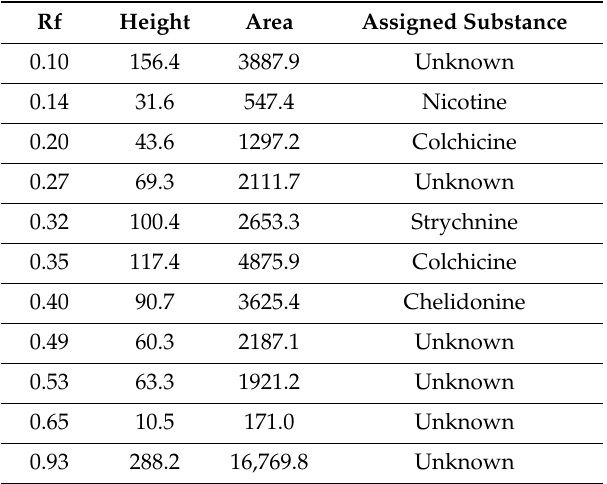
Table 3. HPTLC alkaloid profile of A. aethiopicum methanolic extract.